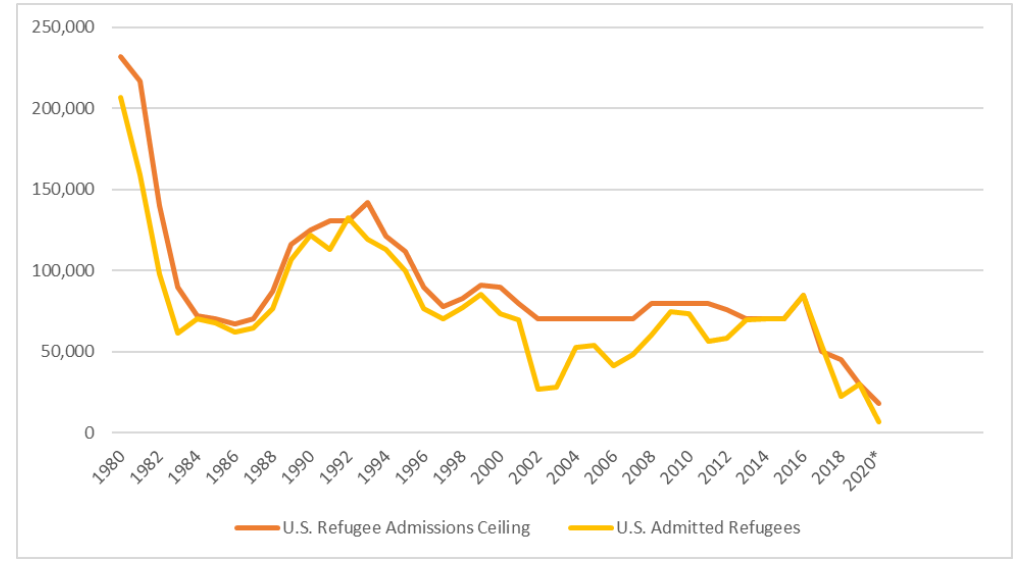
Figure 1. Annual U.S. refugee admissions, 1980–2020. * Figures for fiscal year (FY) 2020 represent Population, Refugees, and Migration (PRM) Refugee Processing Center.